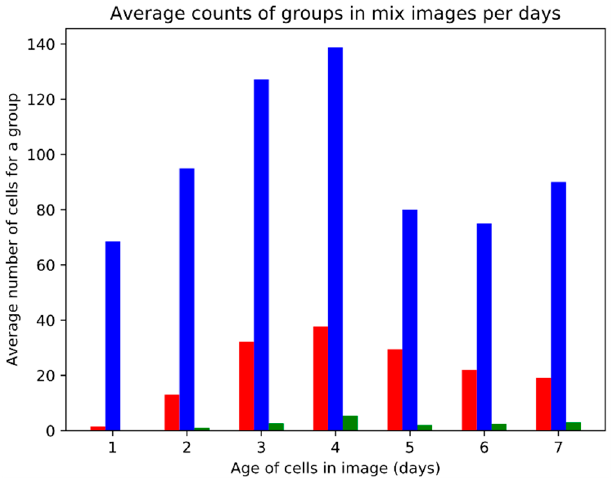
Figure 15. The average numbers of cells within the particular clusters (red, blue, green) as a function of the age of culture.